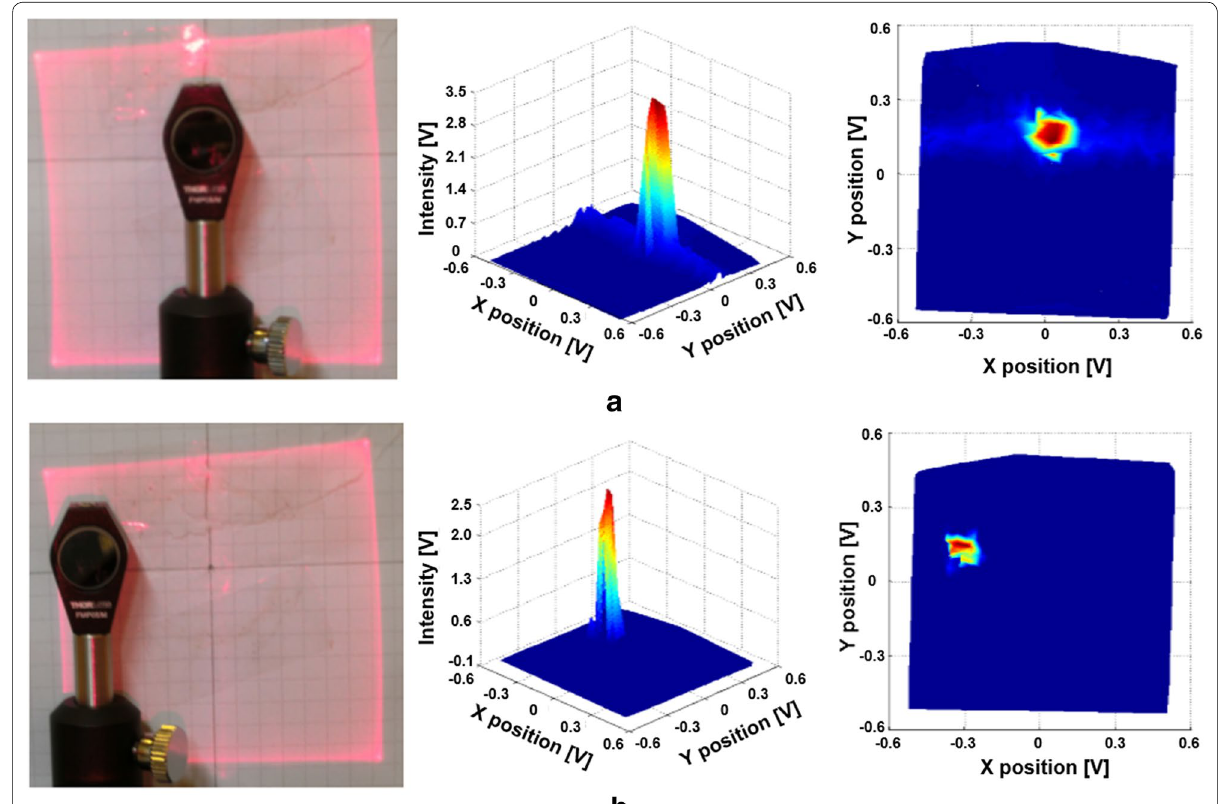
Fig. 8 Position and intensity measurement result using 29 kHz scanner (mirror position inside the scan pattern (left), intensity of the reflected beam vs. xy position (middle), top view of the graph in the middle (right)): a mirror located in the center, b mirror located on the left